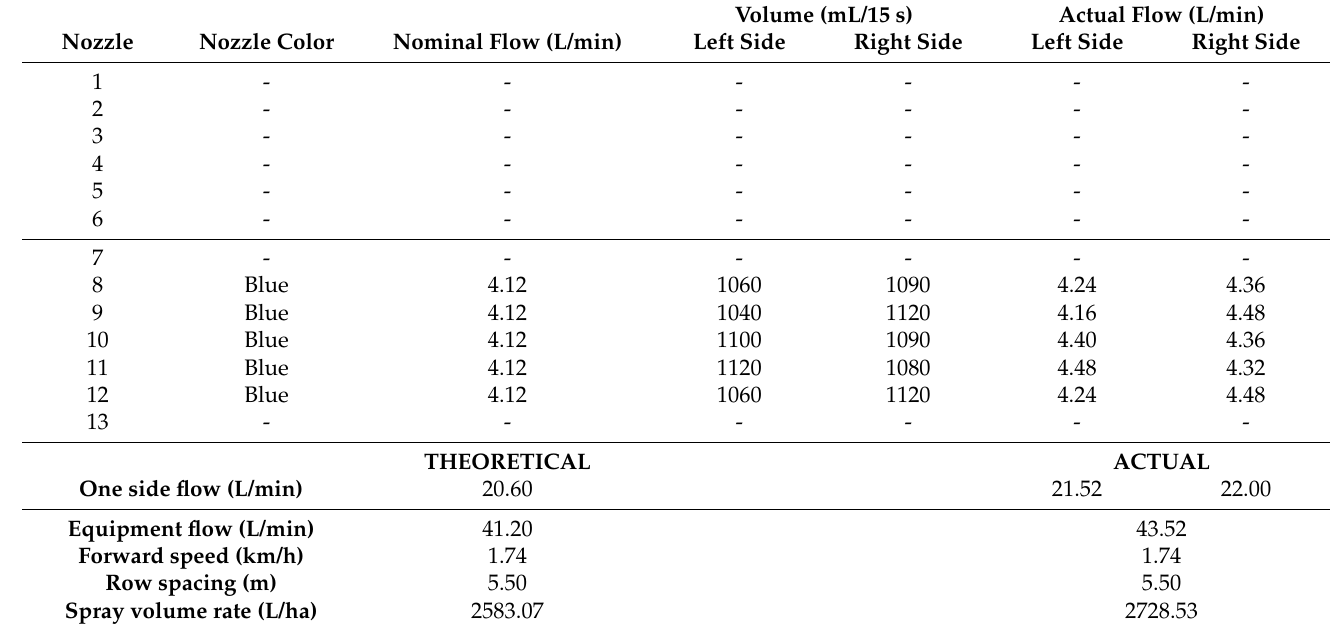
Table A19. Selection and calibration of nozzles for the C1 sprayer, with the following configuration: Adjusted to the vegetation/High & Low fan speed/High spray volume rate/Conventional nozzles (Fine)/Pressure: 15 bar.